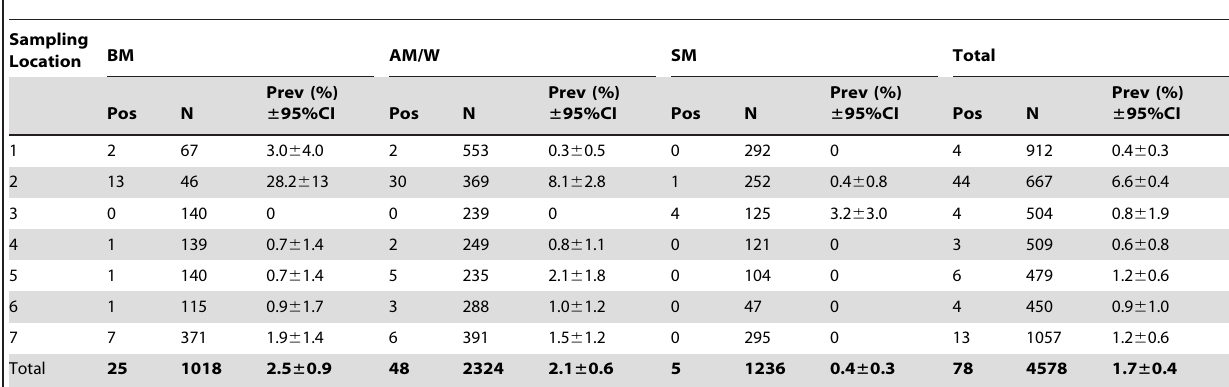
Table 3. Sampling effort and AIV detection in each study site and season.